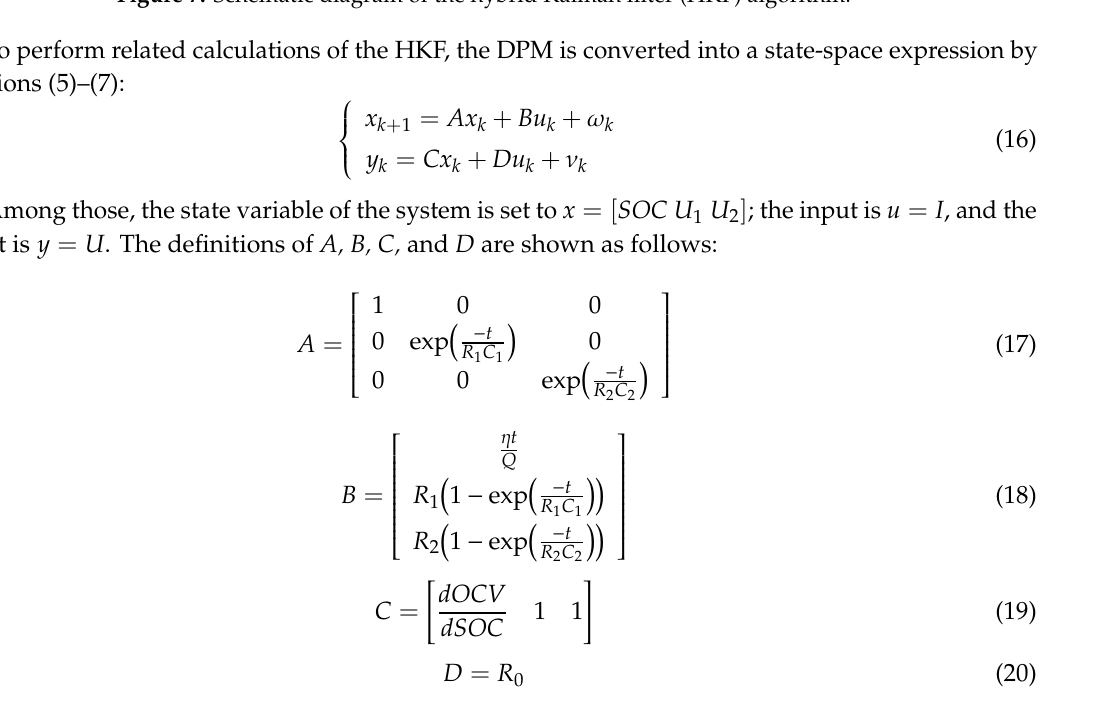
Figure 7. Schematic diagram of the hybrid Kalman filter (HKF) algorithm.